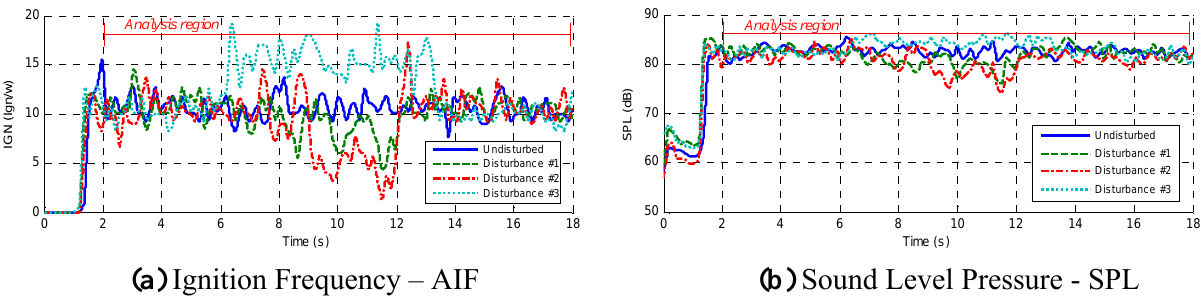
Figure 8. Time Profiles to welding arc sound.